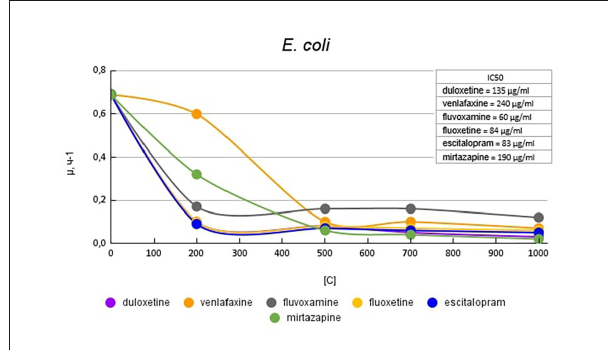
FIGURE3 Specific growth rates of E. coli in the presence of antidepressants.